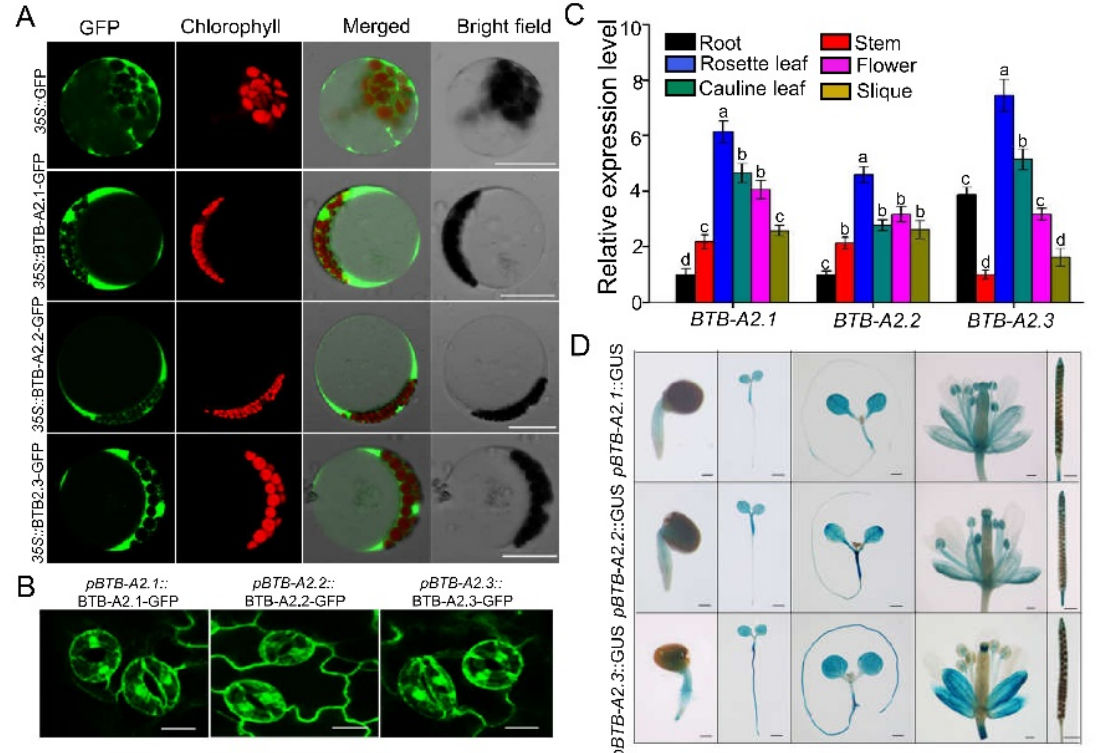
Figure 1. Localization and expression patterns of Arabidopsis BTB-A2.1, BTB-A2.2, and BTB-A2.3. ( A ) Subcellular localization of BTB-A2.1, BTB-A2.2, and BTB-A2.3 transiently transformed in Arabidopsis protoplasts. Images from top to bottom: GFP empty vector, 35S:: BTB-A2.1-GFP fusion protein, 35S:: BTB-A2.2-GFP fusion protein, and 35S:: BTB-A2.3-GFP fusion protein. Columns from 1 to 4 are GFP fluorescence, chlorophyll autofluorescence, merged images, and bright field, respectively. Bars = 20 μm; ( B ) Localization of BTB-A2.1, BTB-A2.2, and BTB-A2.3 in guard cells of pBTB-A2.1::BTB-A2.1- GFP , pBTB-A2.2::BTB-A2.2-GFP, and pBTB-A2.3::BTB-A2.3-GFP transgenic Arabidopsis leaves. Bars = 20 μm; ( C ) Relative expression level of BTB-A2.1 , BTB-A2.2 , and BTB-A2.3 in different tissues of 5-